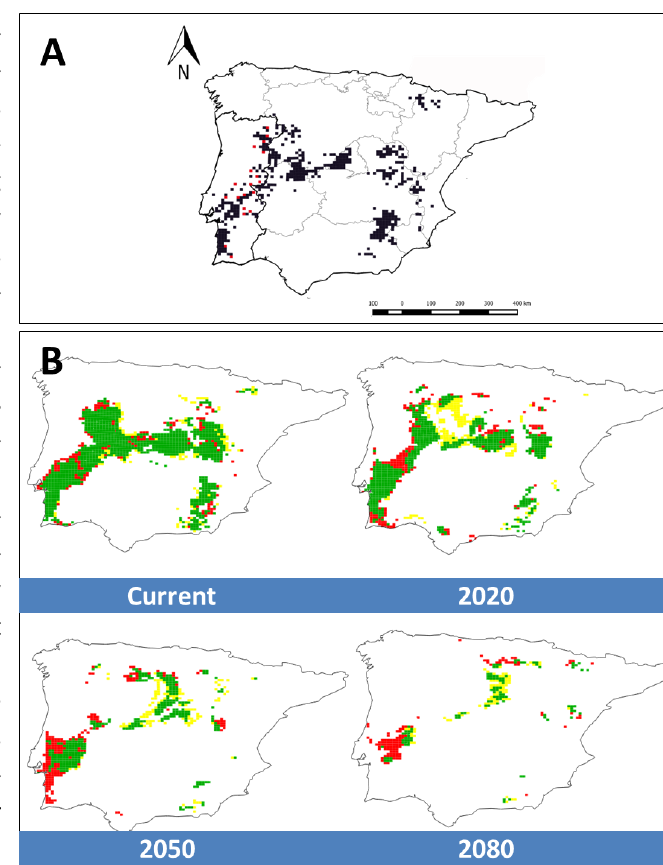
Figure 2. ( A ) The range of the Cabrera vole (black: previously published dataset; red: new occurrences resulting from field work). ( B ) Comparison of the results for ENM1 (based on pub- lished data only) and ENM2 (which includes the published and new occurrences) under the climate change scenarios A1b (scenario B2 in Mestre et al. 2015 and Mestre 2017). Light grey square grids: potential presence given only by ENM1. Medium grey square grids: potential presence given by ENM1 and ENM2. Dark grey square grids: potential presence given only by